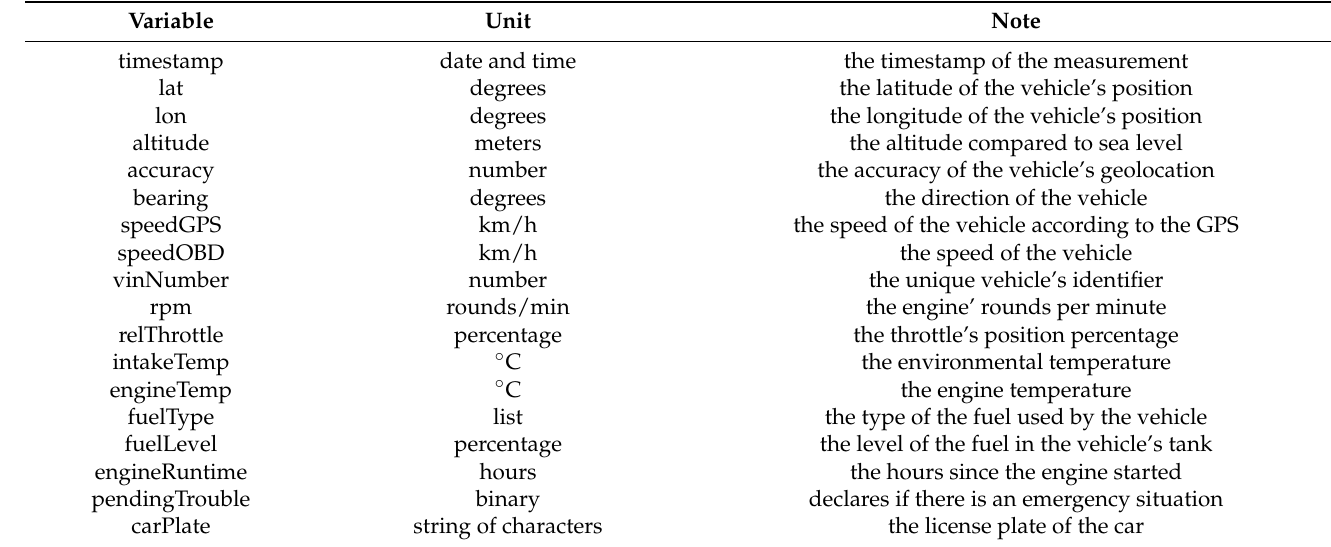
Table 1. Data description collected from every vehicle.